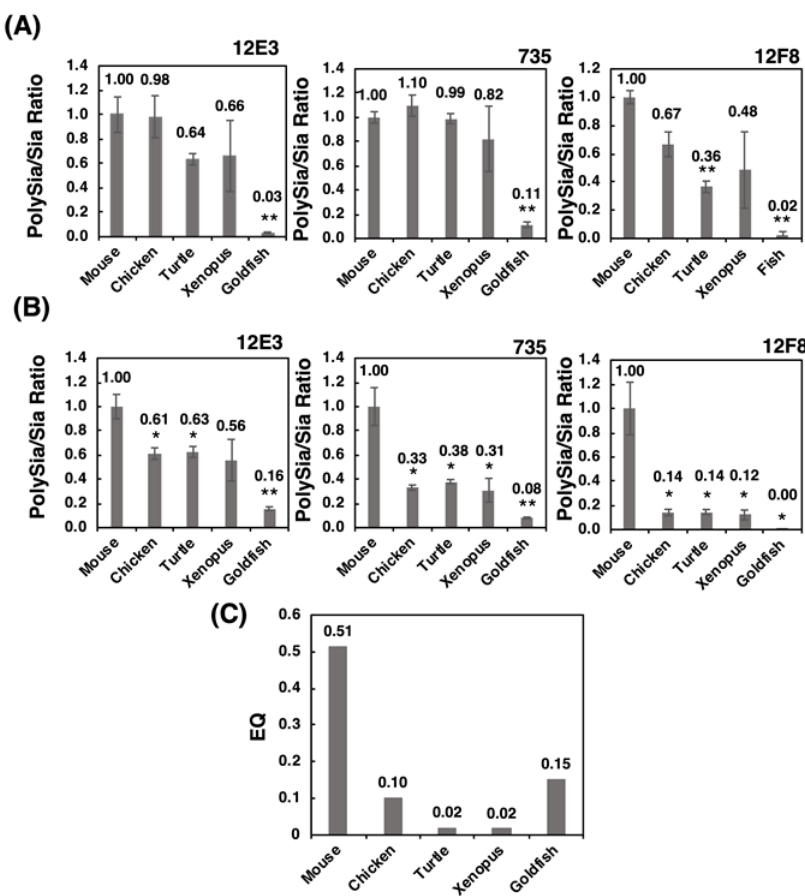
Figure 10. The polySia / Sia ratio and EQ value. The polySia / Sia ratio was calculated according to the intensity of anti-polySia-antibody per protein divided by the Sia amount per protein. ( A ) polySia / Sia ratio evaluated by SDS-PAGE / Western blotting. ( B ) PolySia / Sia ratio evaluated by native-PAGE / Western blotting. ( C ) The EQ value as a standard for evaluating the intelligence of vertebrates was calculated using an equation: EQ = K × [brain weight] / [body weight ] 3 / 4 (K = 10, K was set to 10 for the convenience of calculation, although there were deviations among 8~16. * indicates p < 0.05. ** indicates p < 0.01.